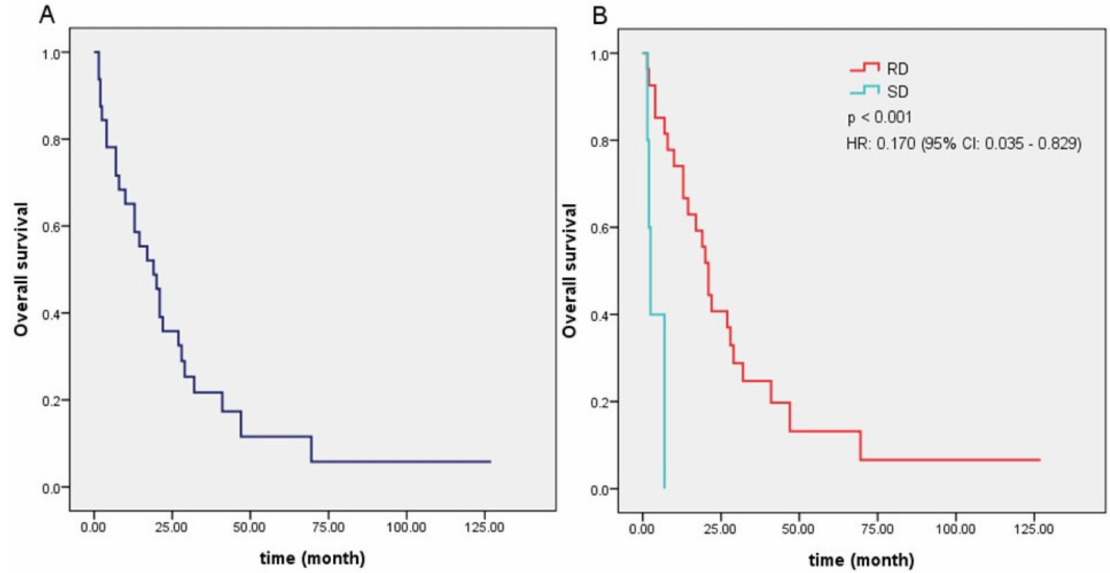
Figure 1. Overall survival for ( A ) all patients over two years and ( B ) regression disease (RD) subgroup and stable disease (SD)